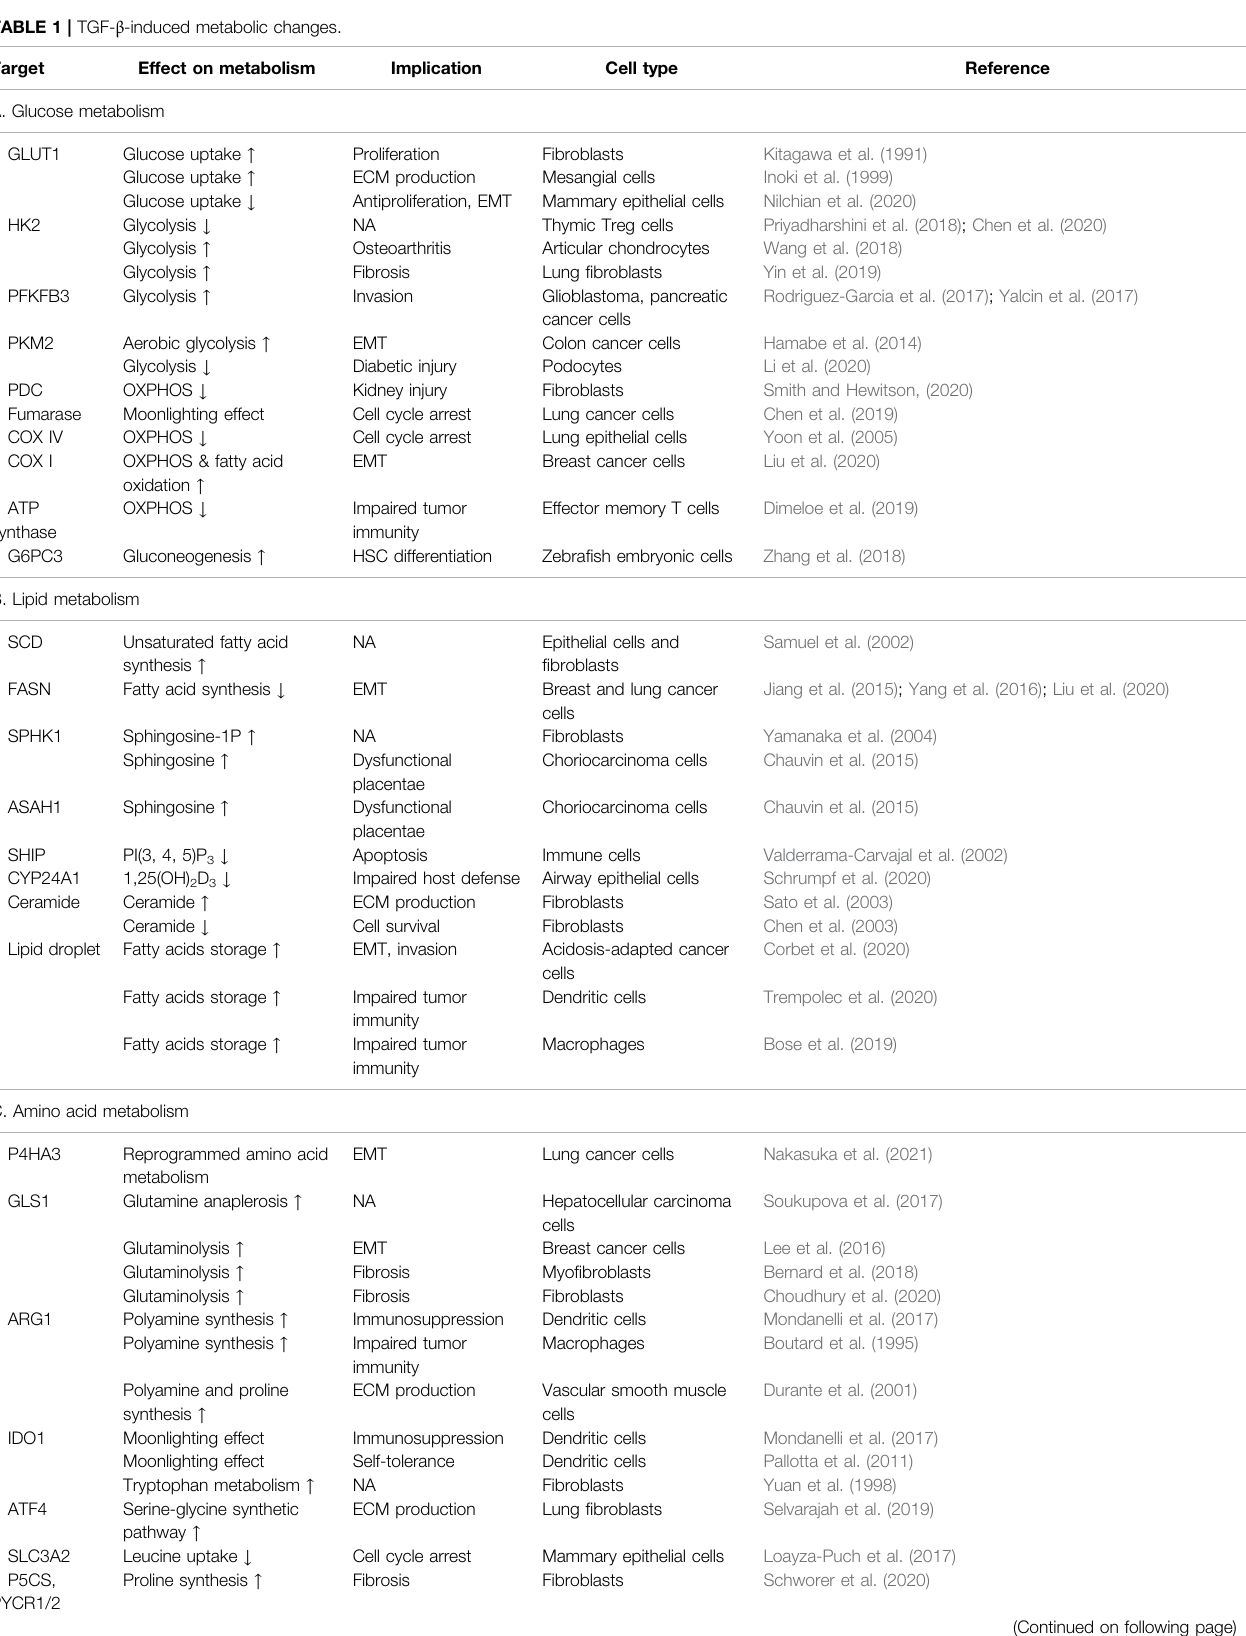
TABLE 1 | TGF- β -induced metabolic